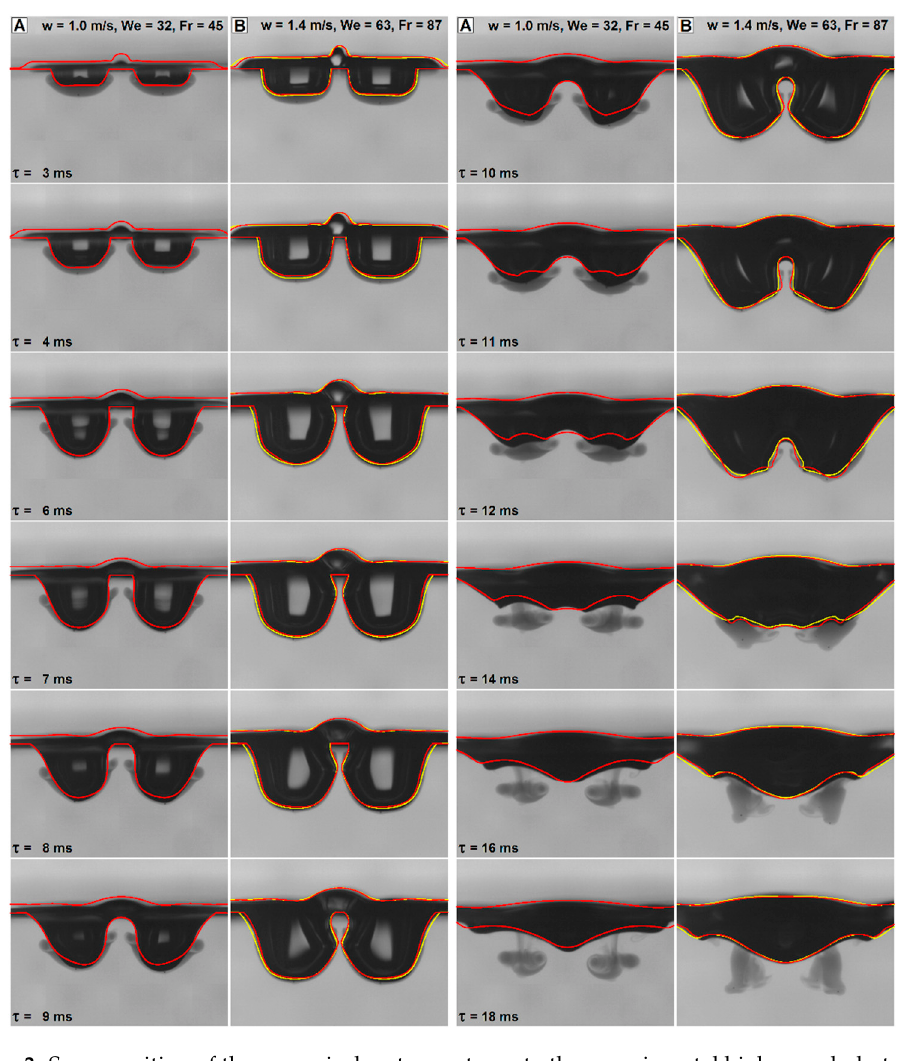
Figure 3. Superposition of the numerical crater contours to the experimental high-speed photos, for case A and case B (for the latter: red line, results from the 12.35 Mcell simulation; yellow line, results for the 1.4 Mcell simulation); time up to 18 ms.